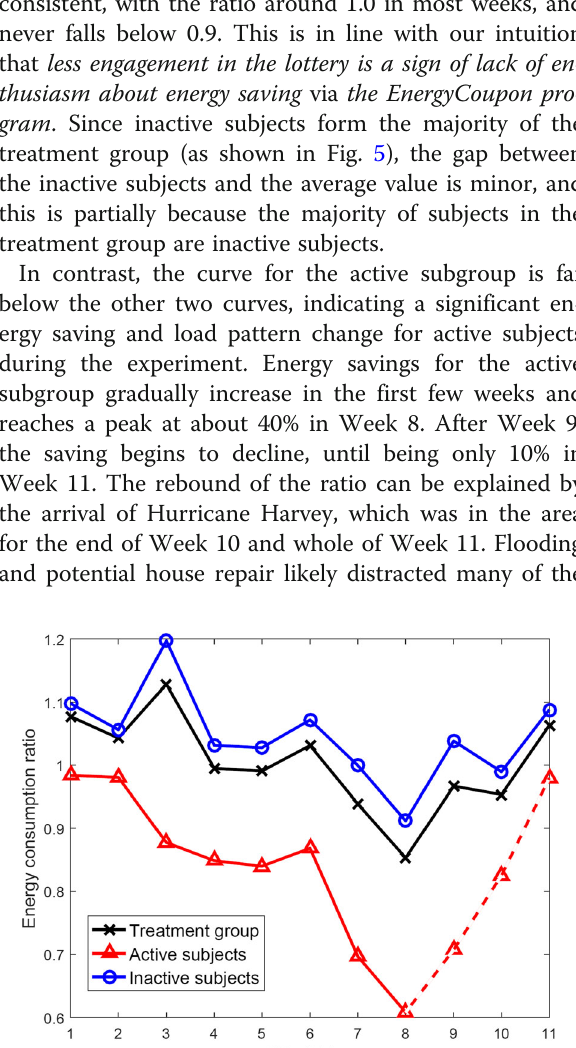
Fig. 8 Daily consumption vs. baseline for active/inactive subjects during the week (7/29 – 8/4/2017). a active subjects, b inactive